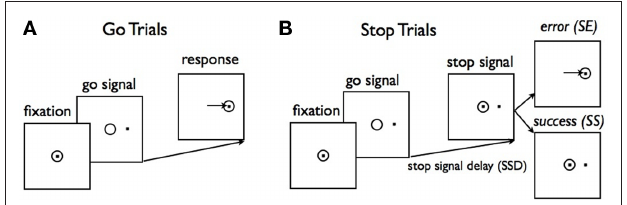
Figure 1 | Schematic illustration of a saccadic version of the stop signal task. (A) On a majority of trials (go trials), a central fixation dot is followed by one of two targets requiring a saccade to the indicated location. (B) On stop trials, the target presentation is followed after a short delay (SSD) by reappearance of the fixation point. A saccade on a stop trial is a stop error (SE), and a successfully canceled movement is a stop success (SS). Figure adapted from Hanes and Schall (1995).